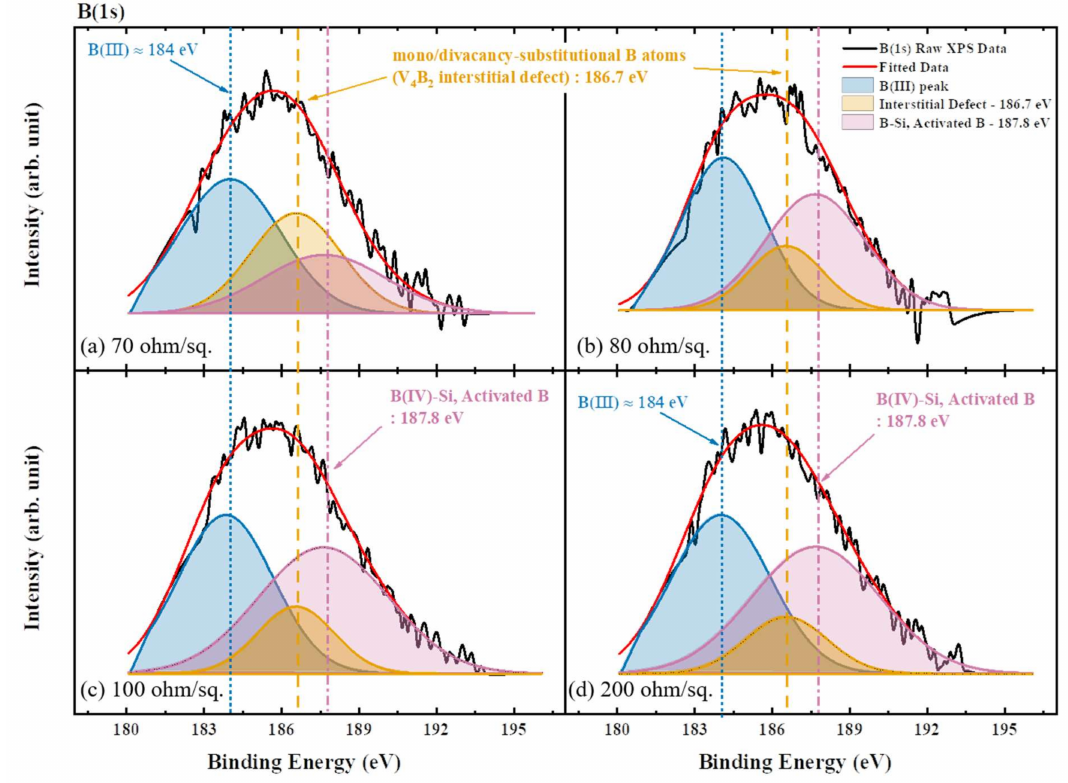
Figure 1. XPS deconvolution of activated boron and the combination of boron vacancy in the p +